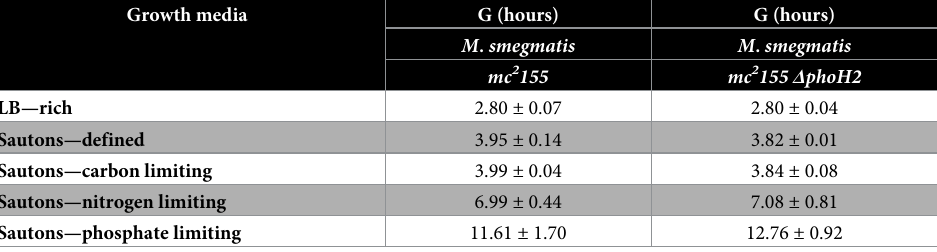
Table 1. Growth rates of M . smegmatis mc 2 155 and M . smegmatis mc 2 155 Δ phoH2 in rich, defined and limiting growth media. Growth media